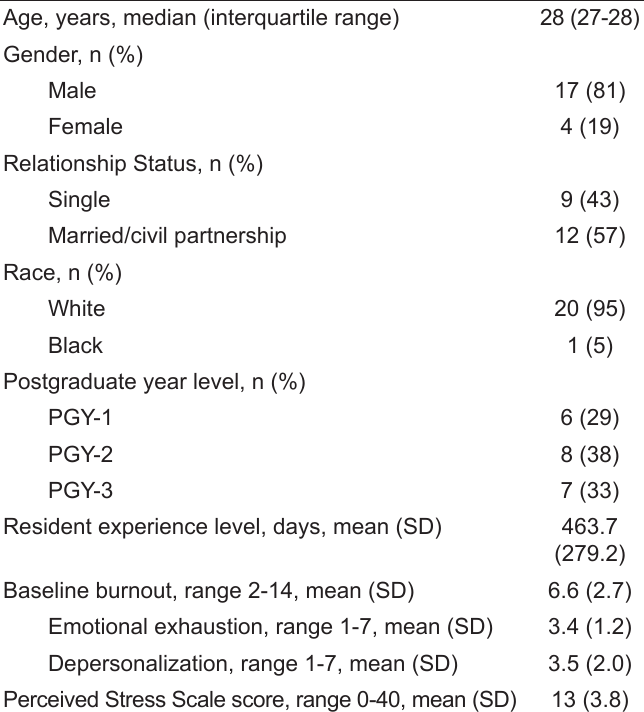
Table 1. Participant demographics assessment (n = 21).